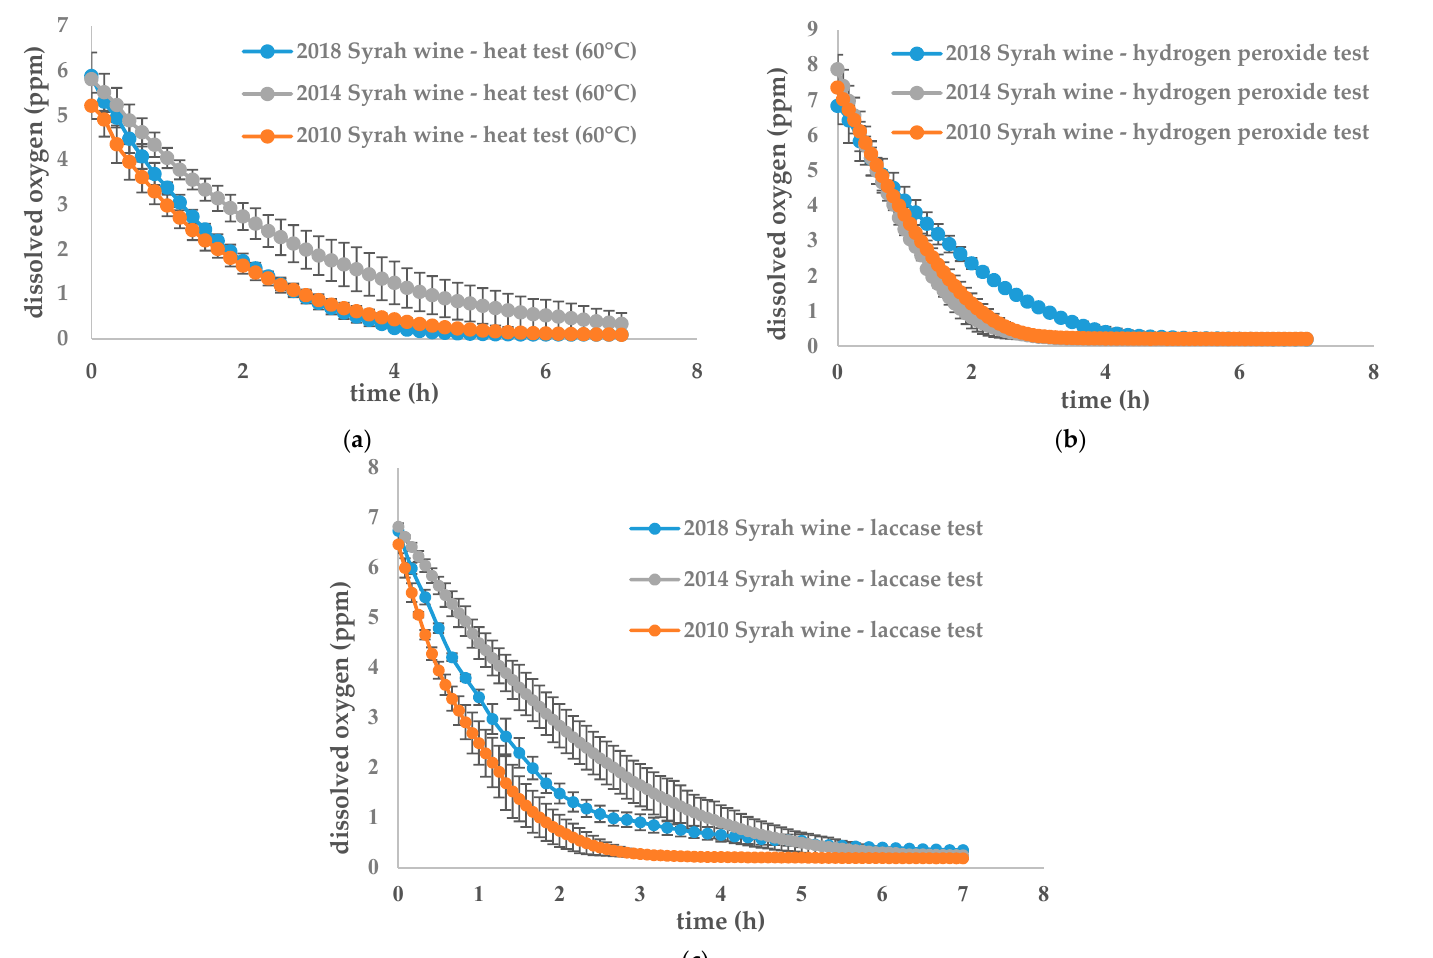
Figure 2. Evolution of dissolved oxygen concentration for three different wines (2018, 2014, 2010) oxidized with ( a ) heat test (60 °C); ( b) hydrogen peroxide test; ( c ) laccase test. Data are available in supplementary data: Tables